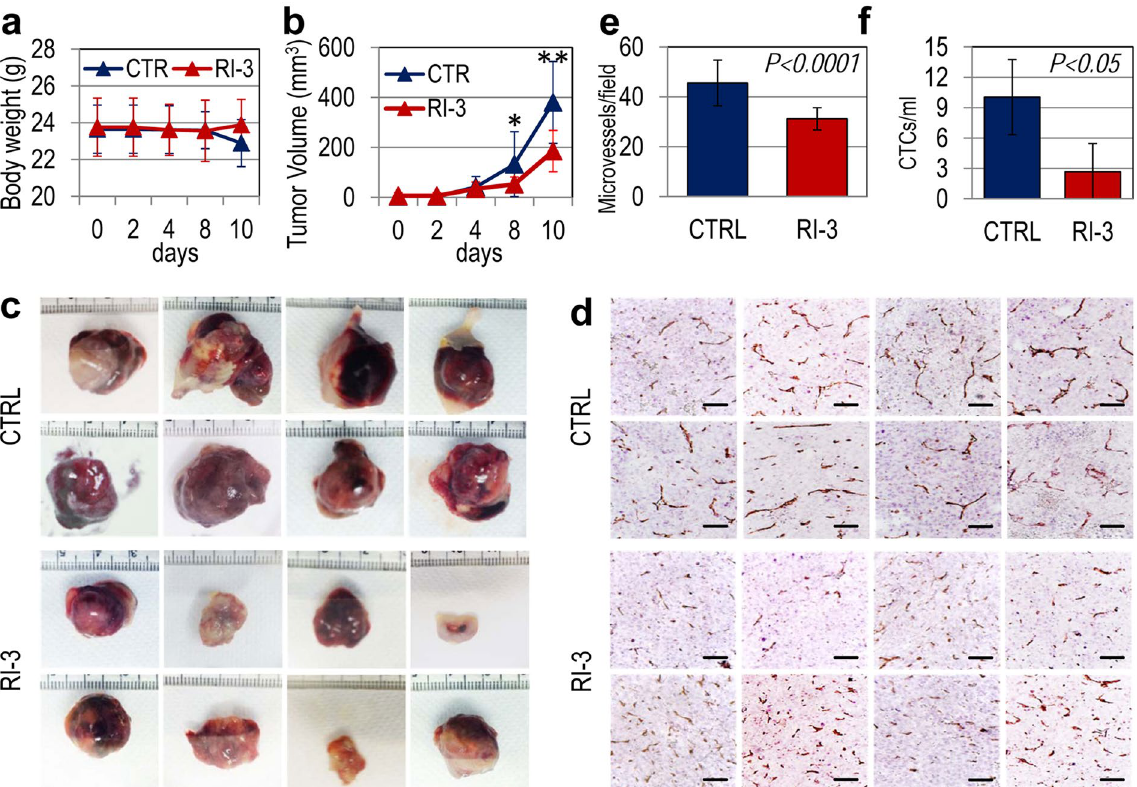
Figure 9. RI-3 reduces tumor growth, intra-tumoral microvessel density and vascular infiltration by sarcoma cells. Sixteen six-eight weeks old, Foxn1nu/nu female nude mice of 23 to 25 g, received an injection of Sarc cells into the right flank as a single-cell suspension (1 × 10 6 cells in 100 µ l of sterile PBS, 96% viability). Eight animals received i.p. injection of 6 mg/kg peptide RI-3 every 24 hr and eight received injections of vehicle only (CTRL). After 10 days, mice were anesthetized and blood samples (~500 µ L/mouse) from the retroorbital venous plexus of mice were collected prior to sacrifice by CO 2 inhalation. ( a ) Body weight measured every 2 days. ( b ) Tumor volumes measured by caliper every 2 days using the formula ½ × (width) 2 × length (mm), where the width and the length are the shortest and the longest diameters of each tumor, respectively. ( c ) Excised tumors from vehicle-(CTRL) and RI-3 - treated mice. ( d ) Tumors were fixed in buffered formalin, processed for paraffin sectioning and the sections immuno-stained with CD31. ( e ) Microvessel density was assessed by counting CD31 positive vascular channels in 5 randomly chosen fields per section, in at least two sections per tumor at × 200 magnification. ( f ) DNA from nucleated cells of murine blood samples was extracted and quantitated by Real-Time PCR using primers targeting Alu-sequences. Number of CTCs was calculated by comparing the obtained amplification curves with others generated in spiking experiments which were included in every